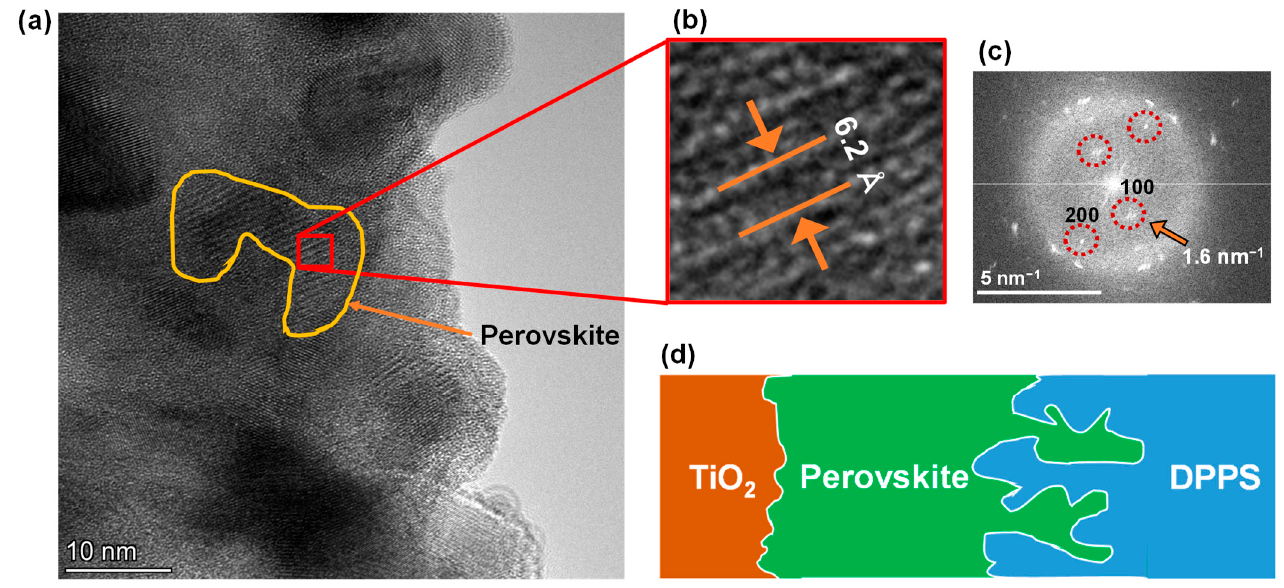
Figure 2. TEM observation of D × 3. ( a ) Microstructure of the perovskite-DPPS layer. ( b ) Enlarged image of ( a ). ( c ) FFT pattern. ( d ) Diagram of bulk-hetero structure.